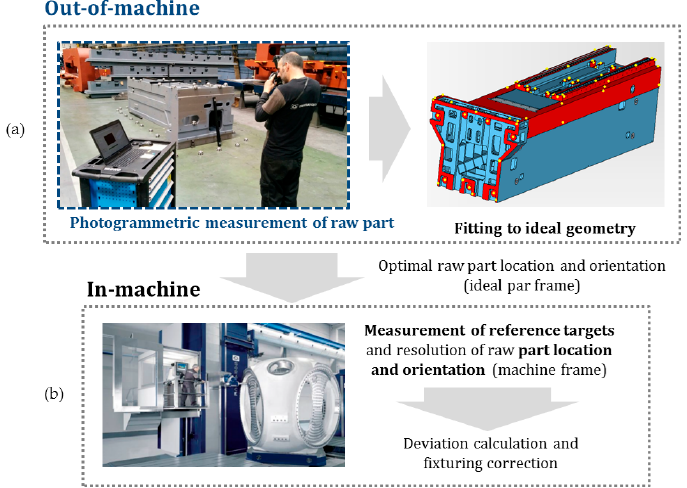
Figure 1. Portable photogrammetry for out-of-machine raw part measurement ( a ) for efficient in-machine alignment process ( b ) of large components prior to machining.